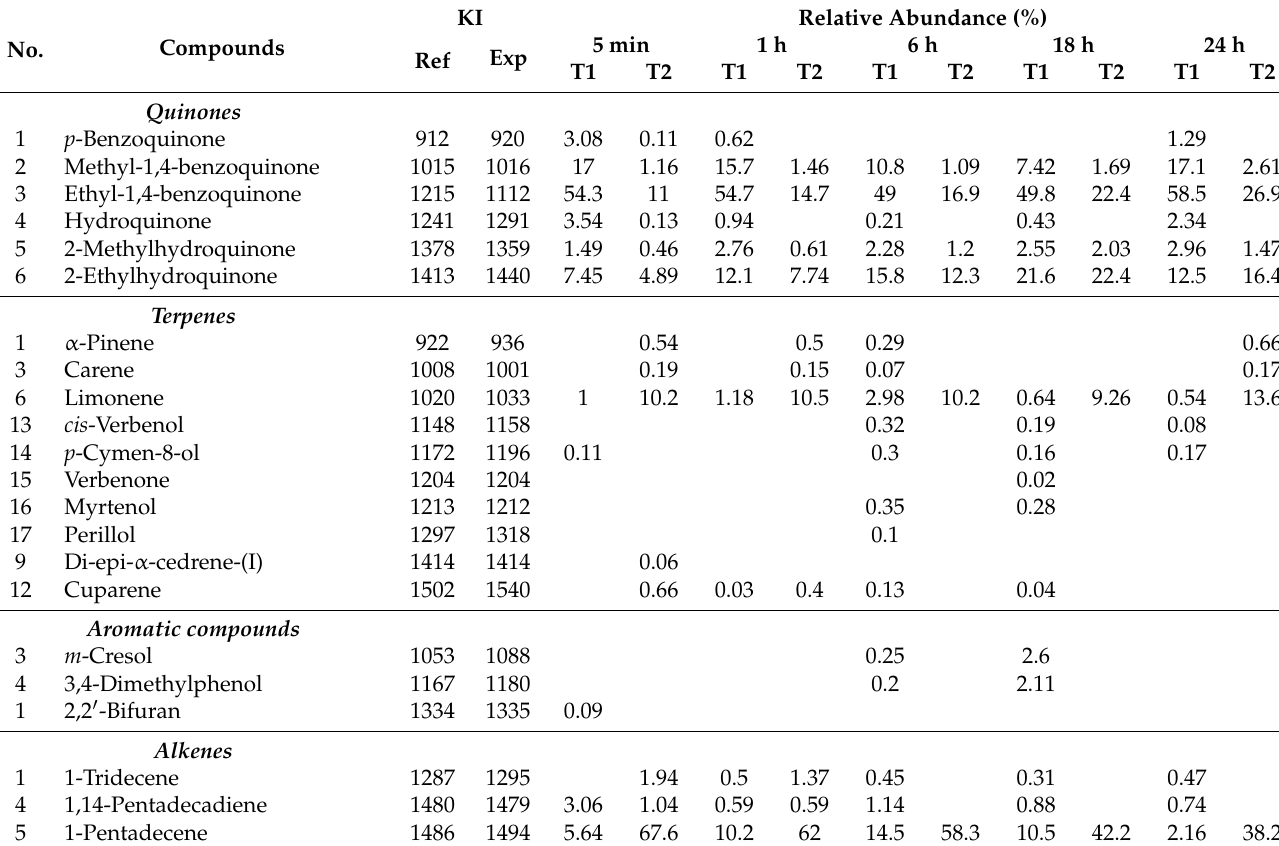
Table 2. VOCs produced by U. dermestoides and collected with PEG